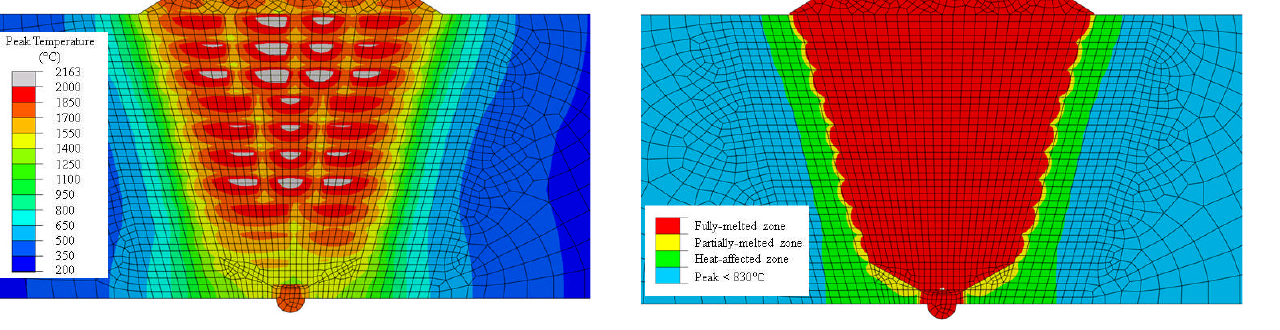
Figure 16. Fusion and thermal